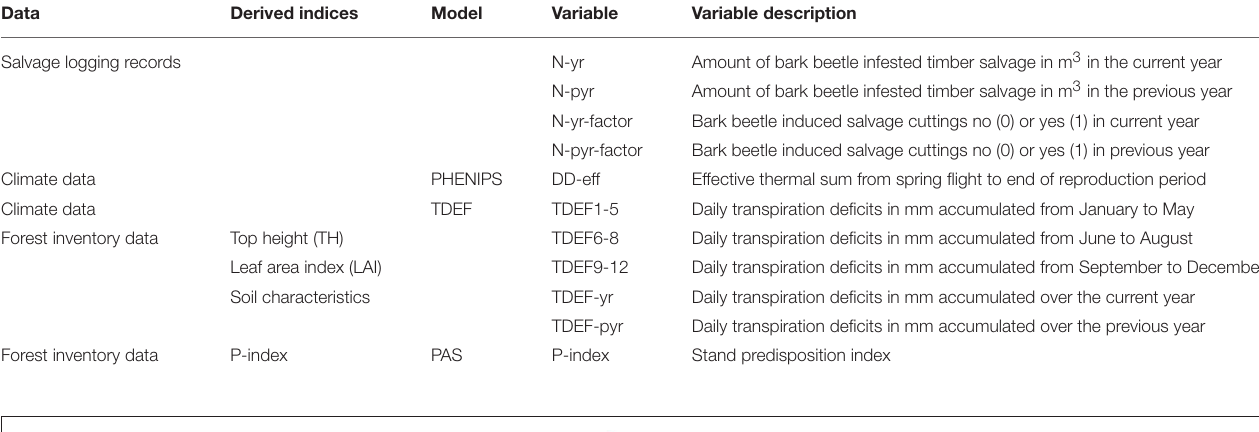
TABLE 1 | Used database, parameters derived from these data as input parameters for the models PHENIPS and TDEF, and variables derived either directly from database or by use of the models.